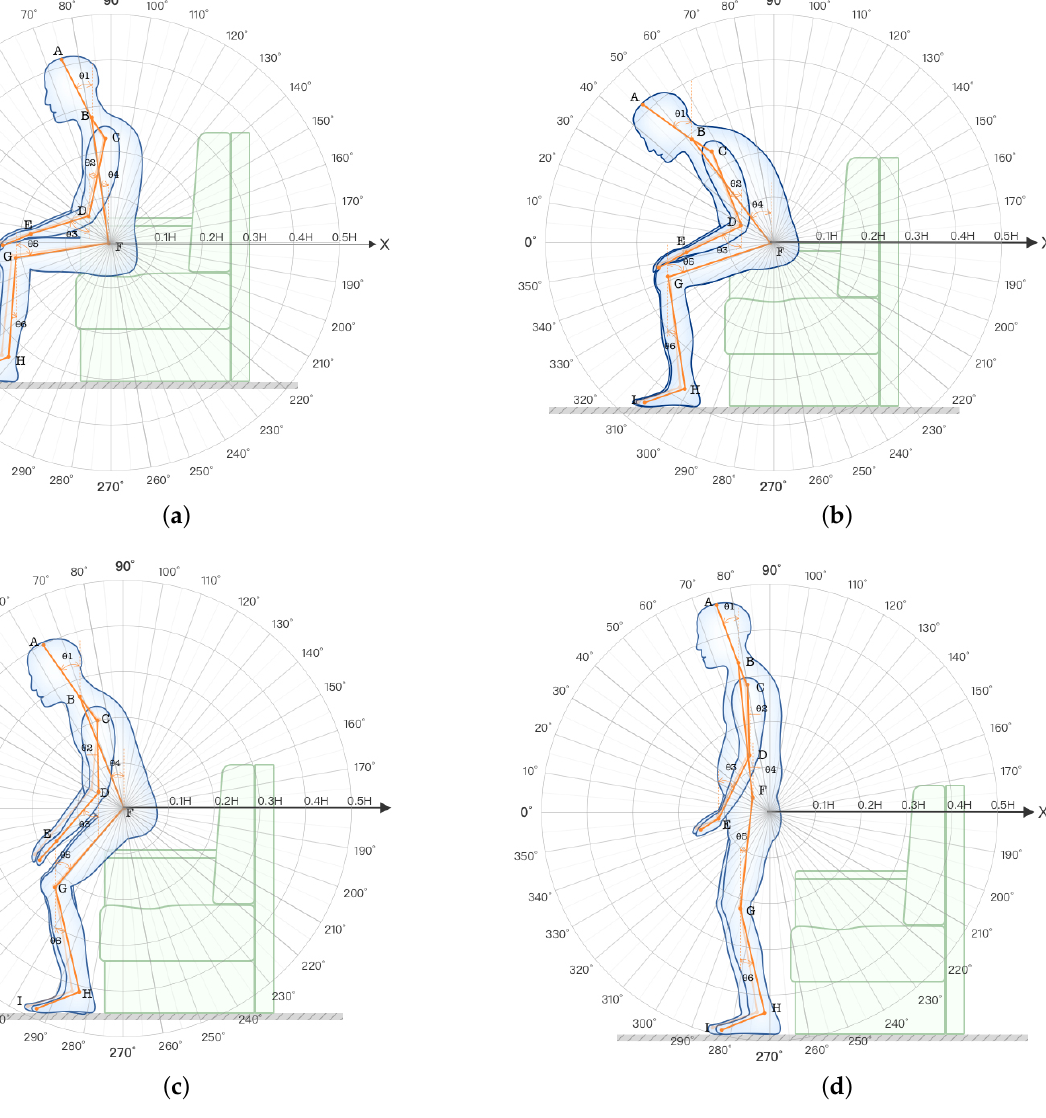
Figure 7. Sofa ‘getting-up’ center posture diagram. ( a ) Sit-to-stand switching cluster stance one. ( b ) Sit-to-stand switching cluster stance two. ( c ) Sit-to-stand switching cluster stance three. ( d ) Sit-to- stand switching cluster stance